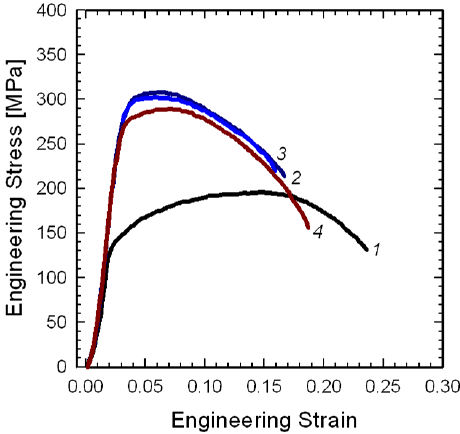
Figure 4. Typical engineering stress—engineering strain curves from tensile testing of the Al 6101 alloy (1) in the T1 condition; (2) after ECAP-C processing; (3) after ECAP-C processing and AA at 170 °C for 12 h; and (4) after ECAP-C processing and AA at 190 °C for 6